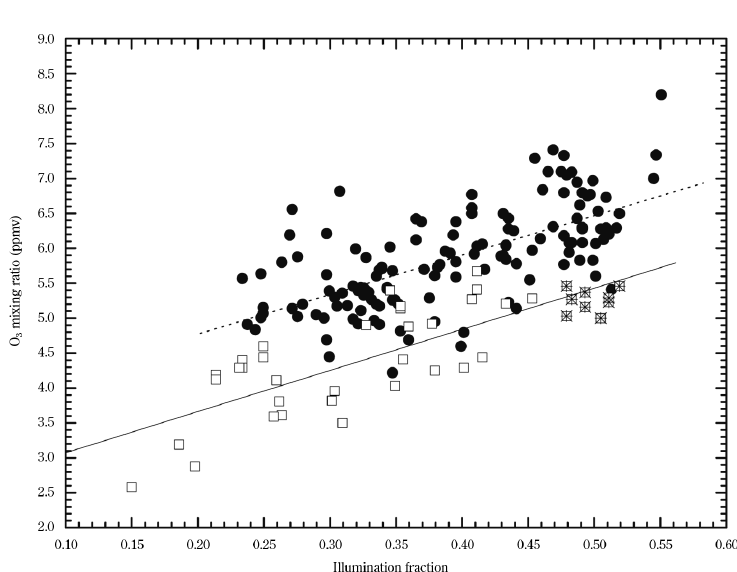
Fig. 7. Correlation scatterplot between all the Testa Grigia GBMS ozone mixing ratio values at 850 K and illumination fraction values along 15-day back trajectories at 850 K (solid circles), and between the same quantities but from the winter 2001-2002 Thule field campaign (open squares; see also Muscari et al. , 2007). Stars superimposed to open squares are measurements from 18-21 March, 2005 (see text for details). Dotted and solid lines are linear fits to Testa Grigia and Thule data, respectively. The illumination fraction is defined as the ratio between the time interval during which the air parcel received solar illumination and the total du- ration of the trajectory. The correlation coefficients are 0.66 and 0.82 for Testa Grigia and Thule data, respec- tively.